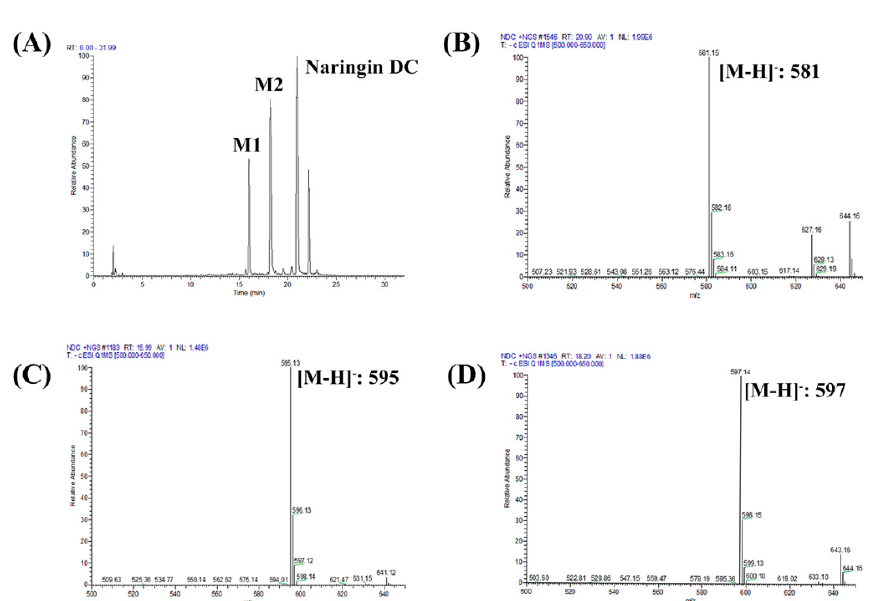
Figure 5. LC-MS analysis of naringin DC and its products produced by CYP102A1 M221 mutant. ( A ) LC-MS chromatogram of naringin DC and its products; ( B ) Naringin DC shows m/z 582; ( C ) The minor product (M1) shows m/z 596; ( D ) The major product (M2) of m/z 598 was found to be monohydroxylated.